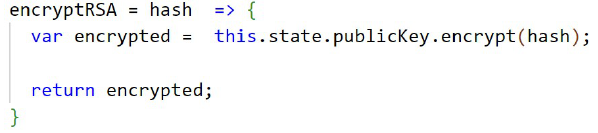
Figure A9. Encrypt RSA.